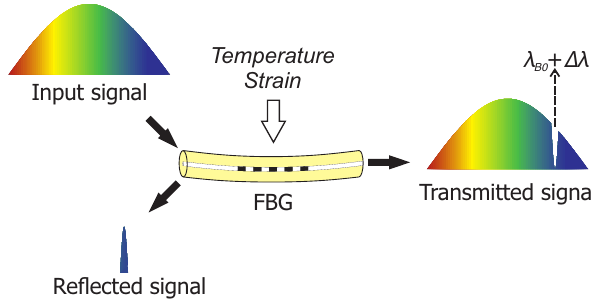
Figure 1. The basic sensing principle of an fiber Bragg grating (FBG)